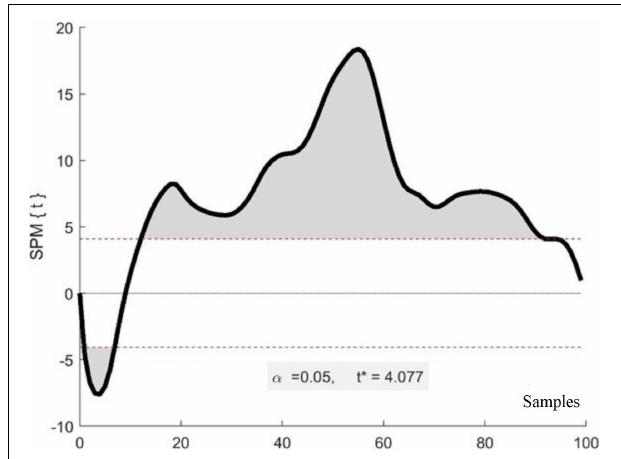
FIGURE 5 | Exemplar results of SPM analysis. The x -axis represents a stride composed of 100 samples (heel strike to heel strike) while the y -axis represents the t -value for each sample of a stride. The shaded areas indicate samples that are significantly different between the two waveforms of the two participants. The * identifies the t